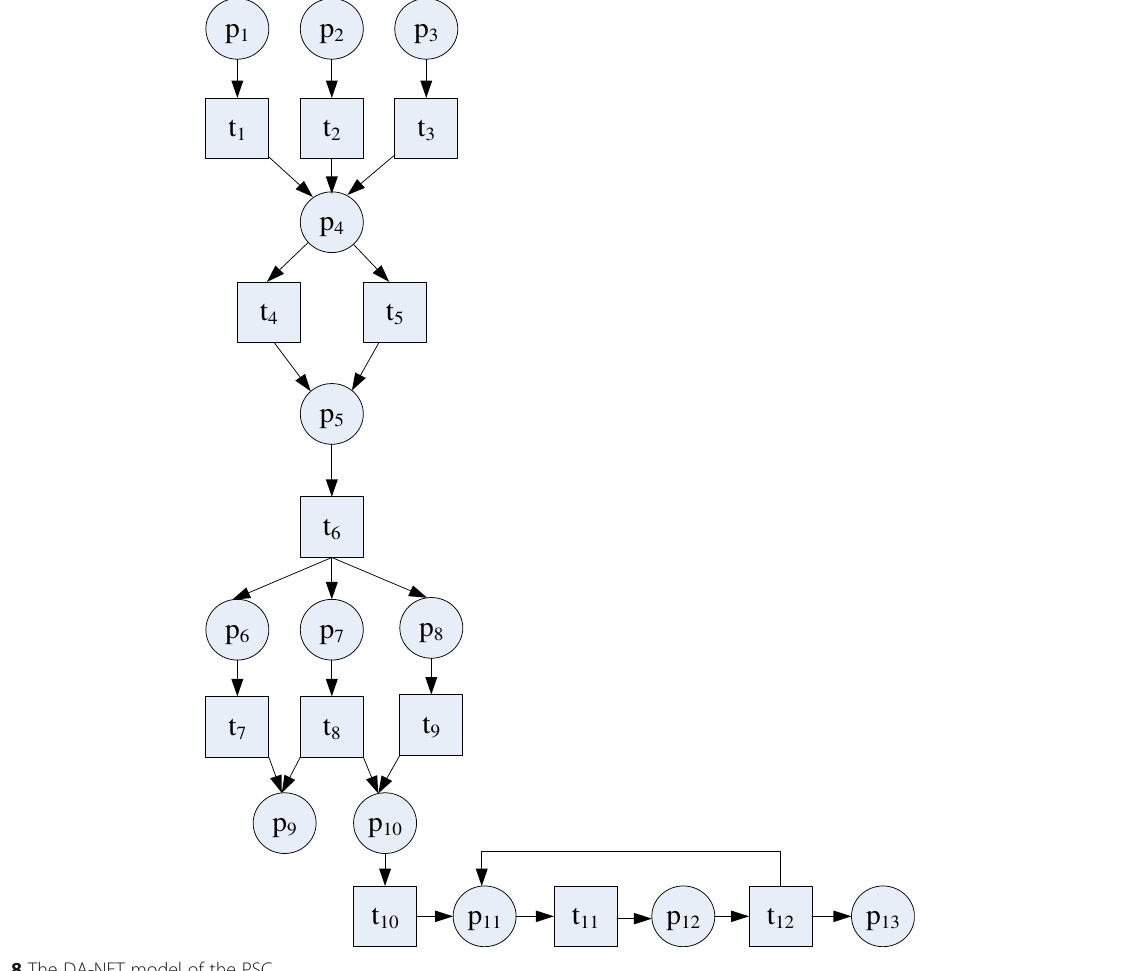
Fig. 8 The DA-NET model of the